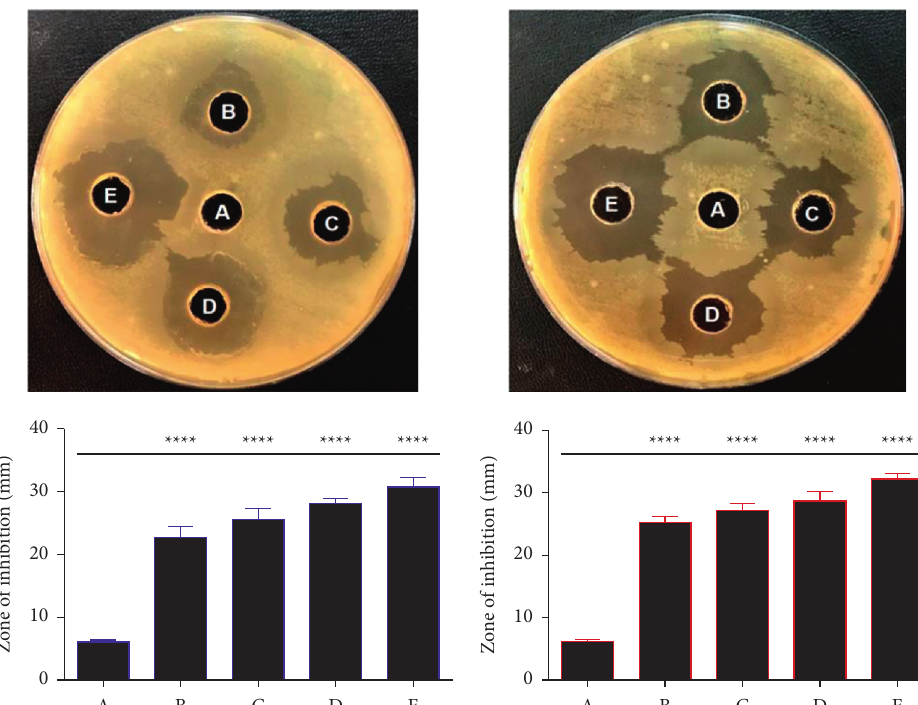
Figure 11: Antibacterial activity of the synthesized NPs against E . coli (blue-lined graph) and S . aureus (red-lined graph). A, control bacterial strain without treatment; B and C, 30mJ/cm 2 and 60mJ/cm 2 of the NPs synthesized without the presence of magnetic field; and D and E with the presence of magnetic fields, respectively. ∗∗∗∗ P ≤